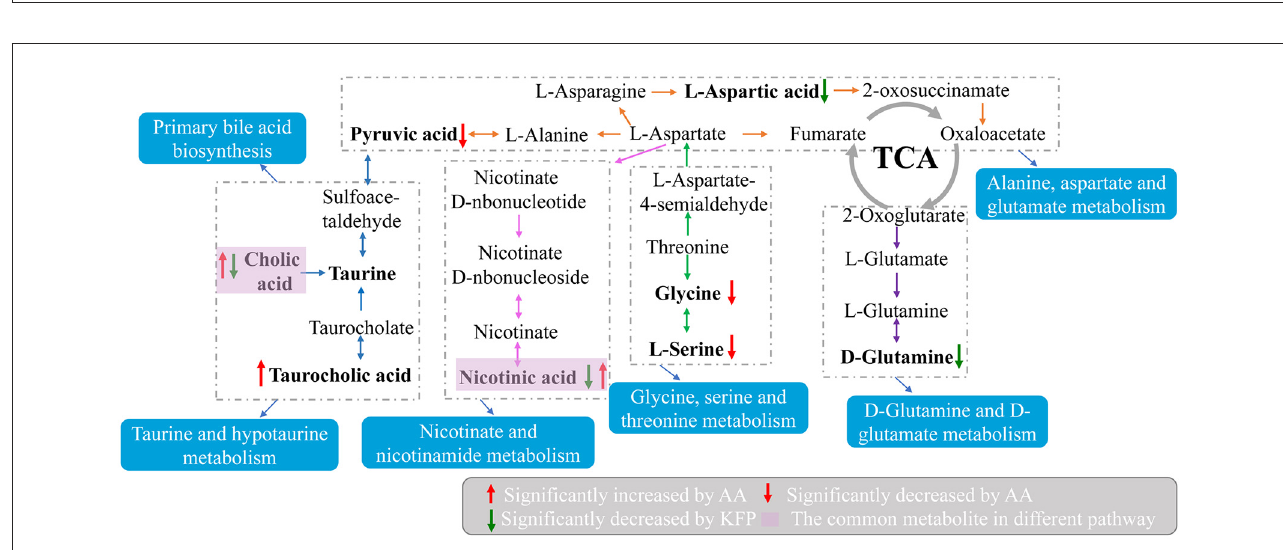
FIGURE8 A schematic overview of the connections between effective metabolites and pathways changed by KFP-M.